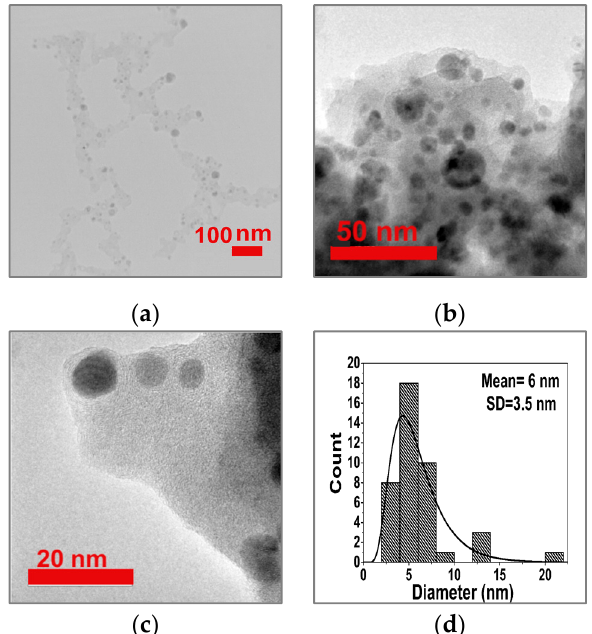
Figure 4. TEM images of Cu NPs embedded in the amorphous gCN support. ( a ) Low-resolution image obtained using a Zeiss-EM10C-80 kV instrument; ( b , c ) High-resolution images obtained using a JEOL JEM2010-200 kV TEM. ( d ) Mean size (nm) and distribution by analysis of ≈ 40 Cu NPs.